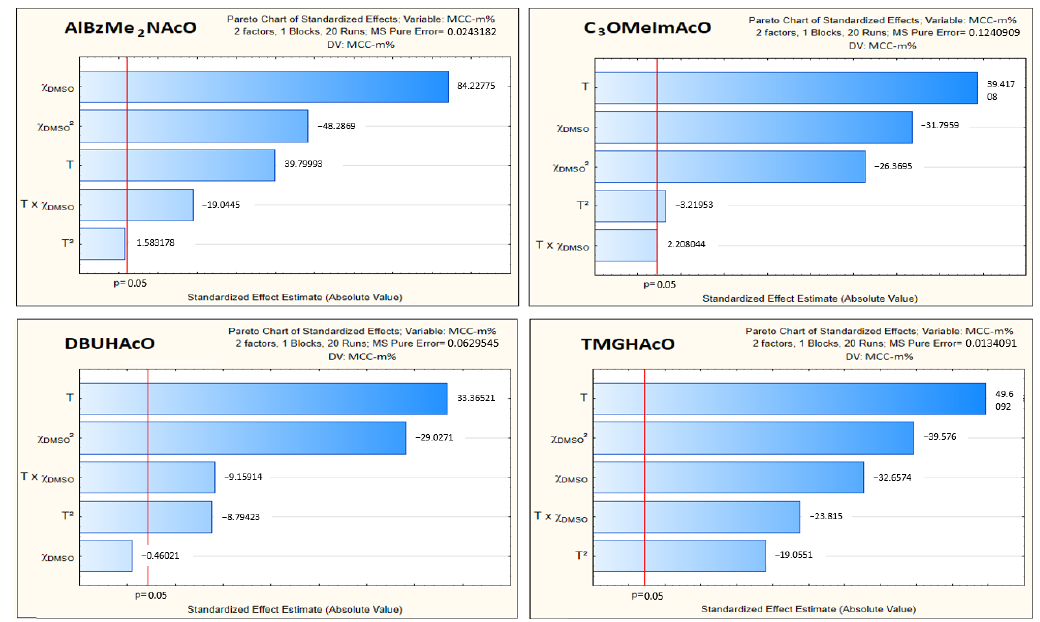
Figure 5. Pareto charts for the relative importance to cellulose dissolution of the temperature (T) and the mole fraction of DMSO ( χ DMSO ). The analysis was carried out by applying a quadratic model to MCC-m% dissolution data.